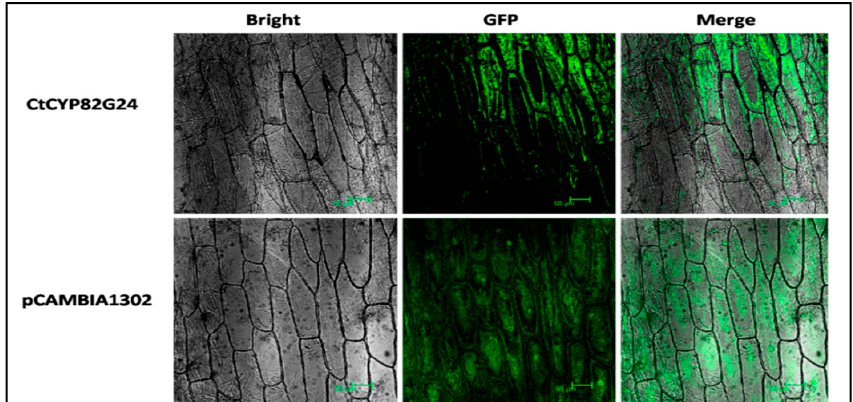
Figure 2. Transient transformation of CtCYP82G24. Subcellular localization of the pBASTA1302-green fluorescent protein (GFP)-CtCYP82G24 in onion epidermal cells. The fluorescence signals were detected using a confocal laser scanning microscope.